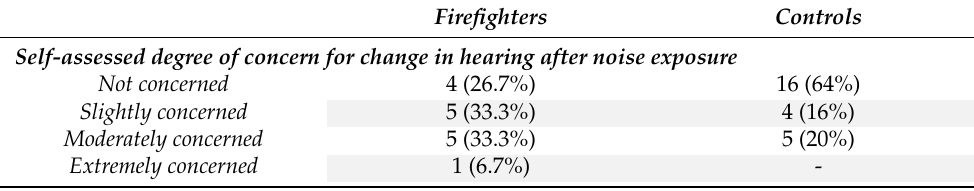
Table 3. Self-reported degree of concern for auditory and vestibular complaints in